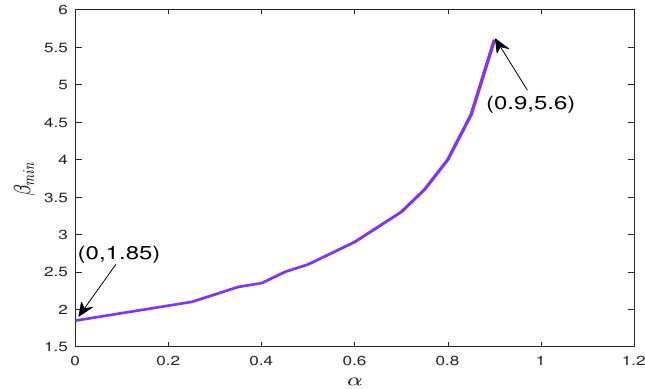
Figure 10. Curve of ϕ vs. ψ min for the OBC